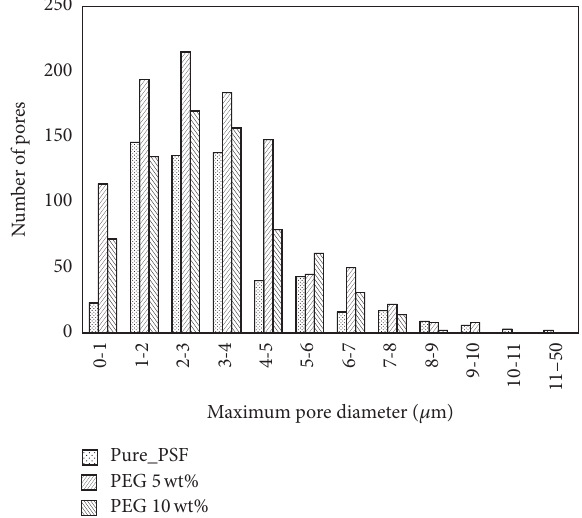
Figure 5: Comparison of the maximum pore diameter distributions between pure PSF membranes and PSF/PEG membranes with a loading of 5 and 10wt%,